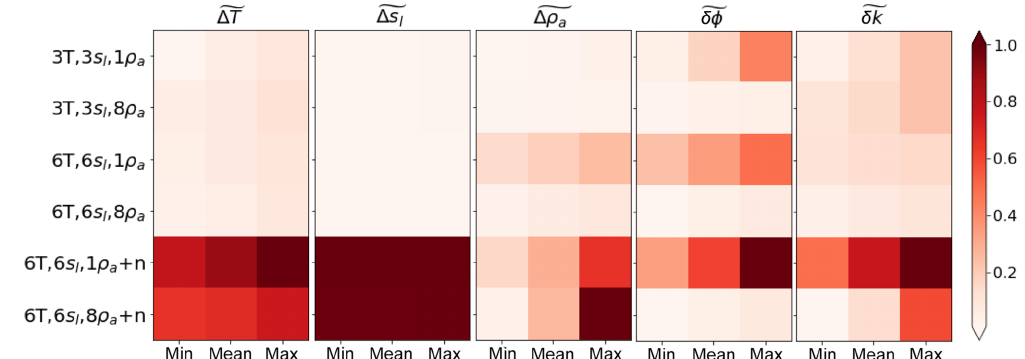
Figure 6. Five matrix tables presenting fitness metrics between synthetic model values and values obtained by the parameter estimation method using simplified meteorological data. Matrix tables from left to right correspond to the normalized root-mean-squared errors for temperatures, liquid water saturations, and apparent resistivities as well as to the normalized Euclidian distances between synthetic (true) and estimated values of porosities and thermal conductivities. Each matrix value was normalized by dividing it by the matrix maximum value. The normalized values are indicated by tildes.